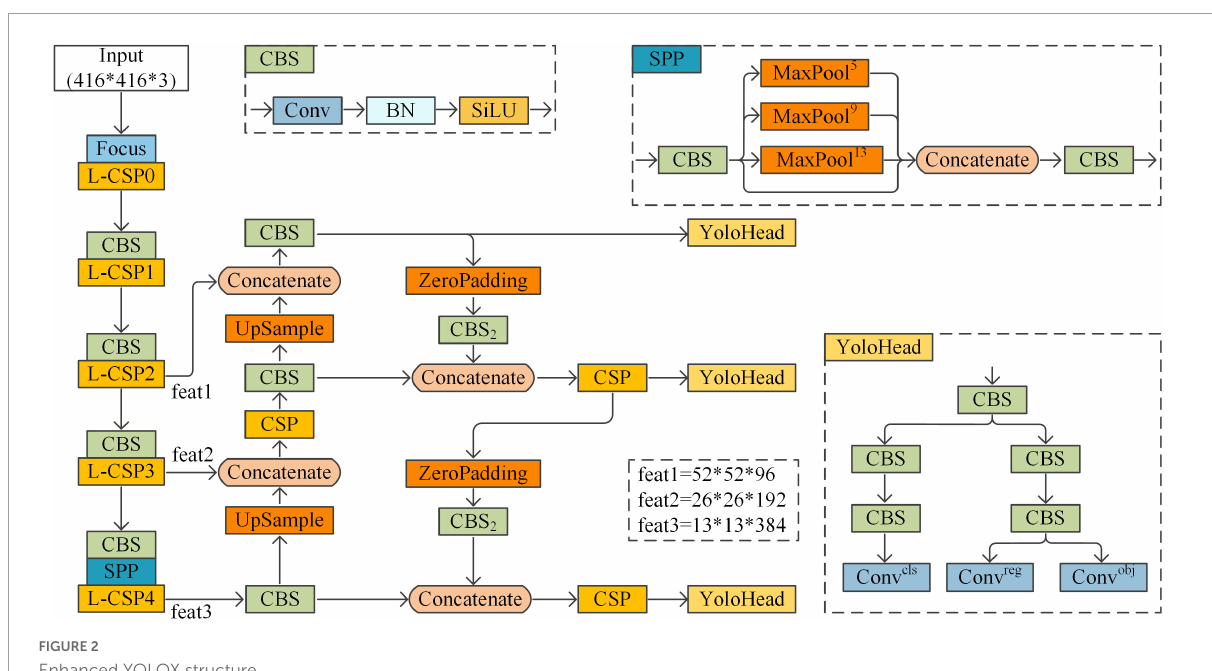
FIGURE2 Enhanced YOLOX